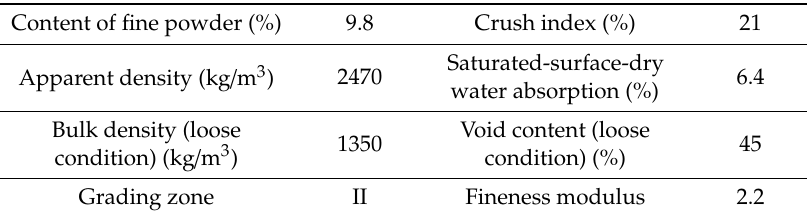
Table 3. The physical properties of the produced CRFA.